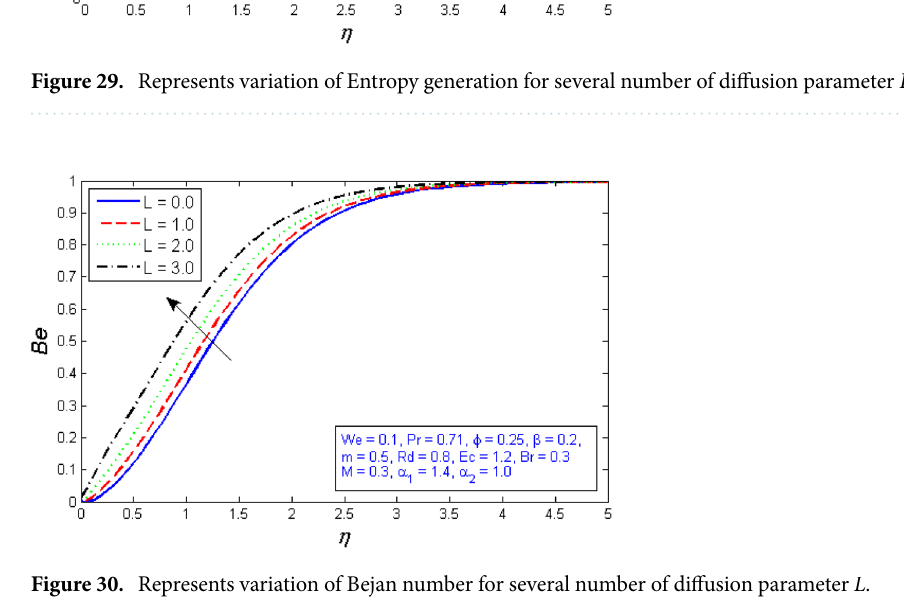
Figure 30. Represents variation of Bejan number for several number of diffusion parameter L